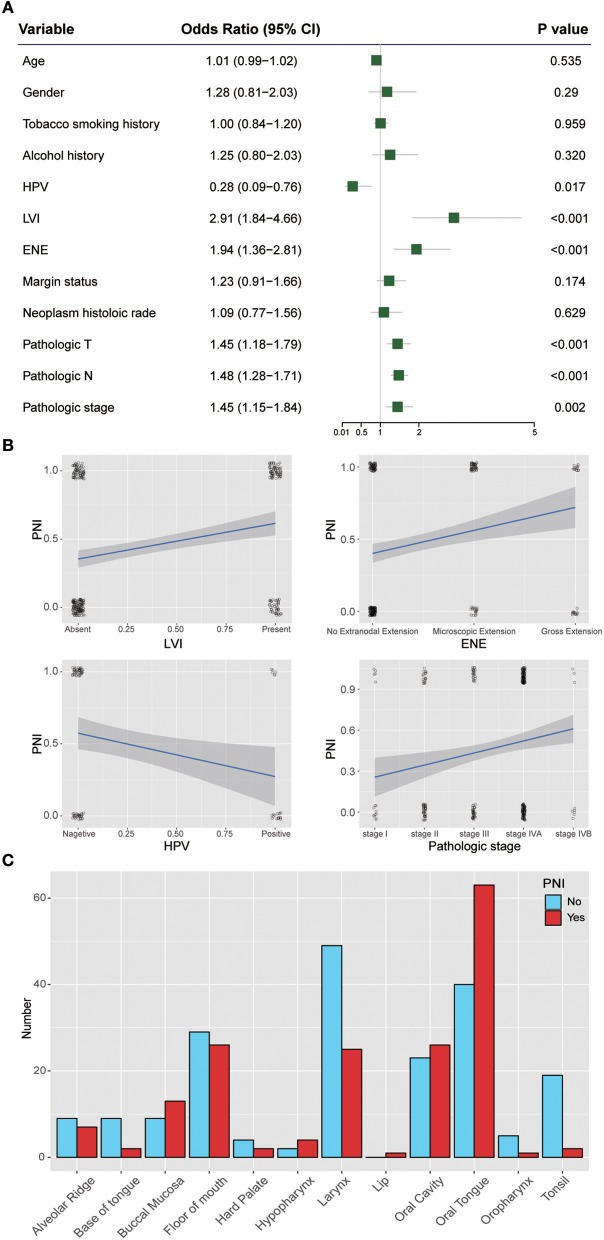
(A) Relative risk for PNI with regards to age, gender, smoking history, alcohol history, HPV status, LVI, ENE, margin status, neoplasm histologic grade, pathologic T category, pathologic N category, and pathologic stage. (B) Regression curve for the relationships of PNI with LVI, ENE, HPV status, and pathologic stage. (C) Relationship between PNI and the anatomical distribution of the primary tumor. HPV, human papillomavirus; LVI, lymphovascular invasion; ENE, extranodal extension.